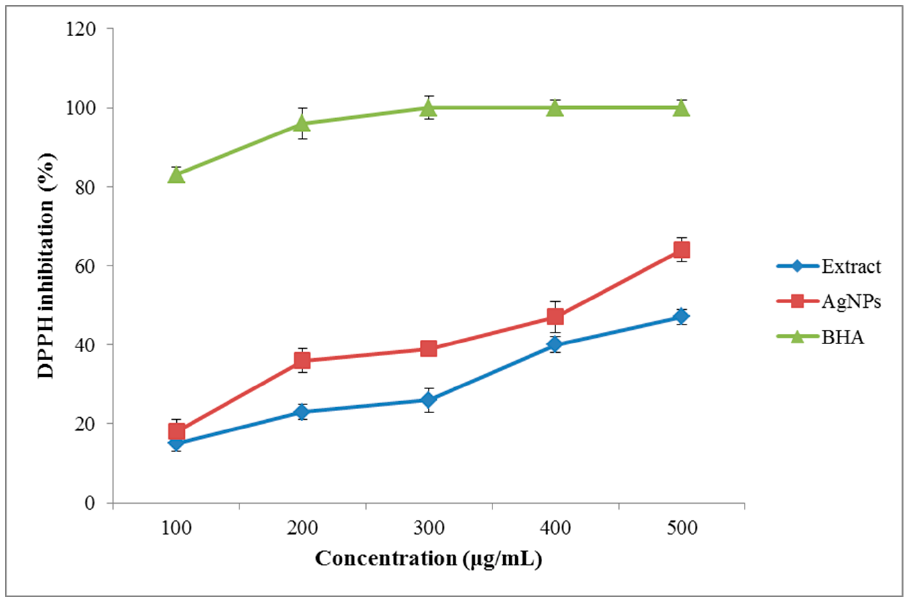
Figure 5. The DPPH scavenging activity of the A. tribuloides root extract and the greenly synthesized AgNPs at different concentrations.